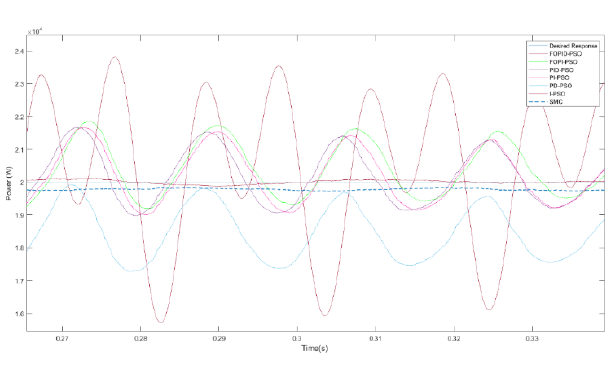
Fig. 24. PSO with SMC and all optimal controllers compared in zoom